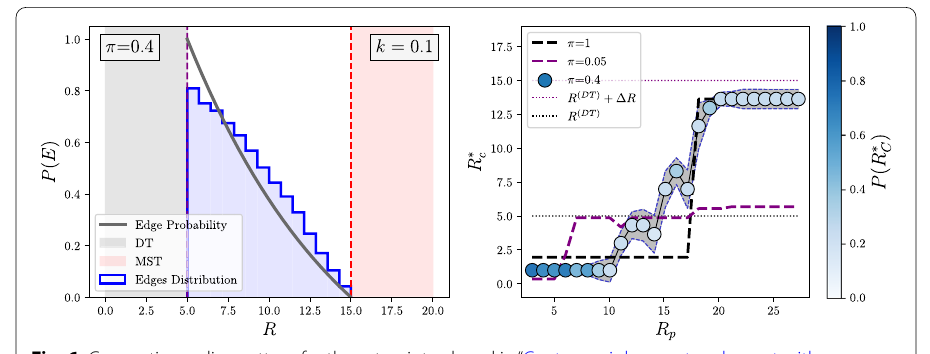
Fig. 6 Congestion radius pattern for the setup introduced in “Center‑periphery entanglement with non‑uniform edges distribution” section, with N = 6000 , L = 20 , R ( DT ) = 5 , and (cid:31) = 10 . Hybrid region is generated by overlapping a fraction π = 0.4 of DT edges sampled from the distribution in Eq. (2), with k = 0.1 . In the left panel, the blue histogram describes the final distribution of these edges. The right panel reports the congestion radius R c as a function of the parch radius R p . The black and purple dashed line report the result related to π = 1 and π = 0.05 respectively, where all the edges and approximately no one have been added, and match the situation described in “Center‑periphery entanglement with spatial overlap” section. The dotted line refers to the edge distribution shown in the right panel, where circles are located at the statistical mode over an ensemble of 100 realizations. In this case transition exhibits a smooth, rather than abrupt, profile as a consequence of the non‑tight discontinuity in the edge